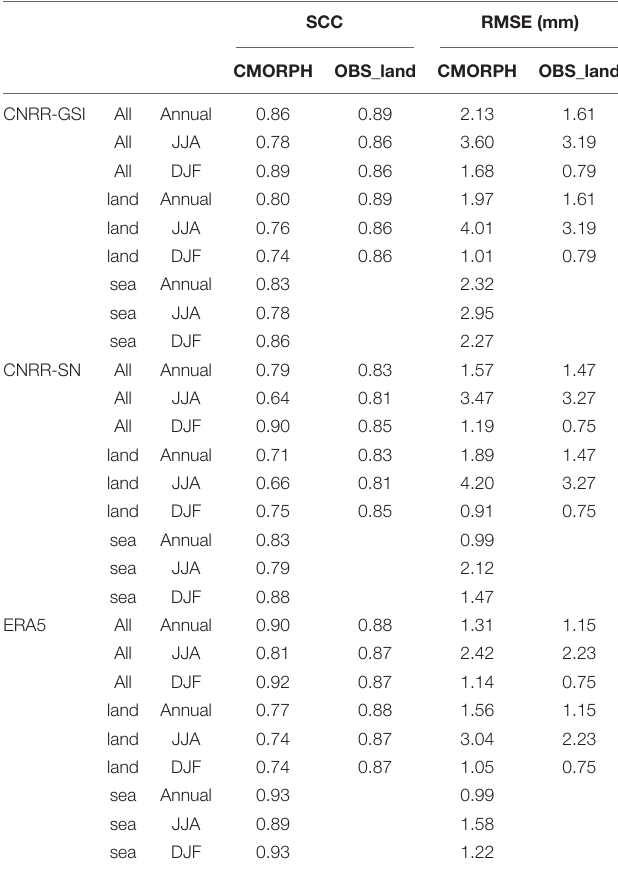
TABLE 2 | The SCCs and RMSEs of annual, summer (JJA) and winter (DJF) precipitation between reanalyses and observations over land and ocean. SCC RMSE